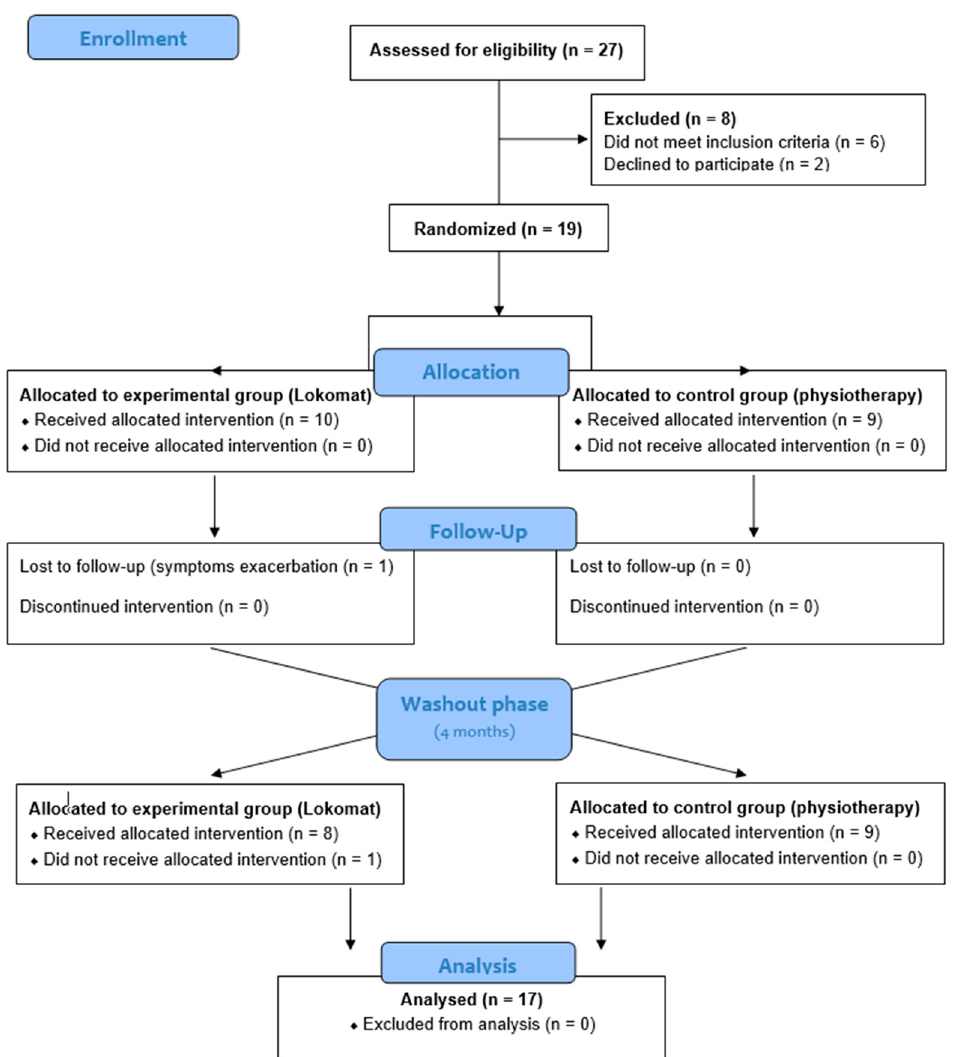
Figure 1. CONSORT flow diagram for the crossover randomized trial.